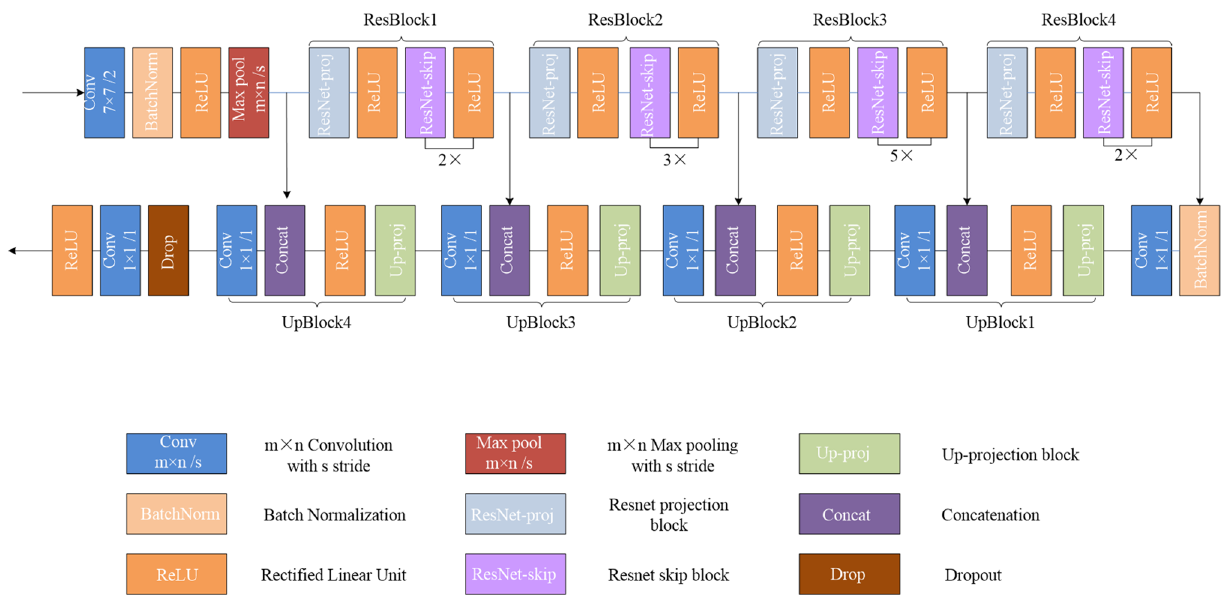
Fig. 2 Structure diagram of the deep learning-based depth prediction